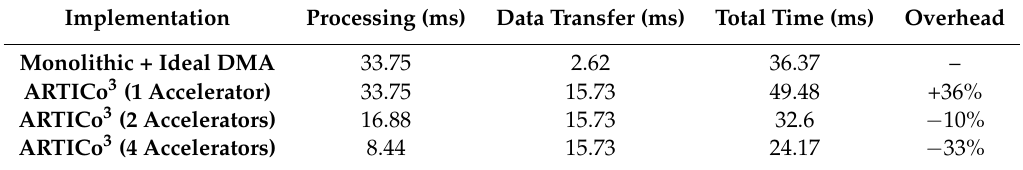
Table 6. Performance evaluation for AES-256 CTR: custom design (theoretical bound) vs. ARTICo 3 (evaluation based on processing 512 KiB @ 100